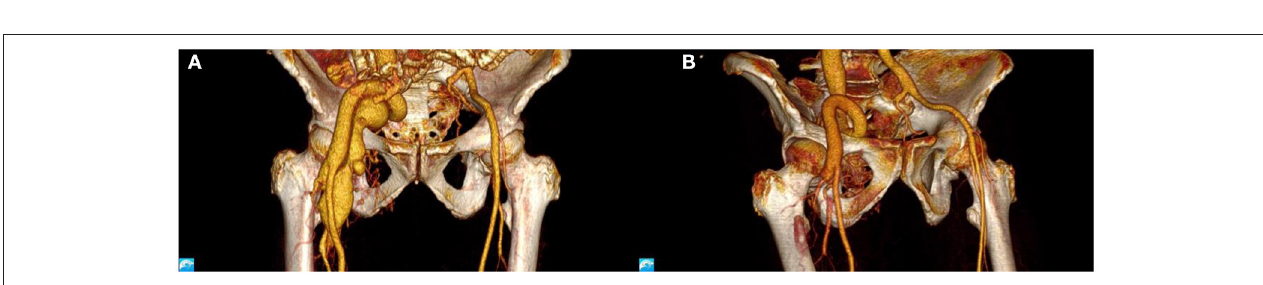
FIGURE 4 | CT angiography, 3D reconstruction: (A) before and (B) after the